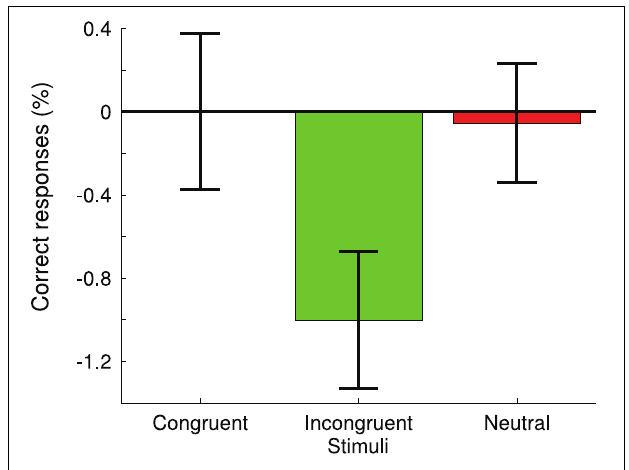
FIGURE 2 | Differences of pre- vs. post-retreat test mean correct responses to the Stroop task for all types of stimuli. Standard error of the mean are shown for each condition.